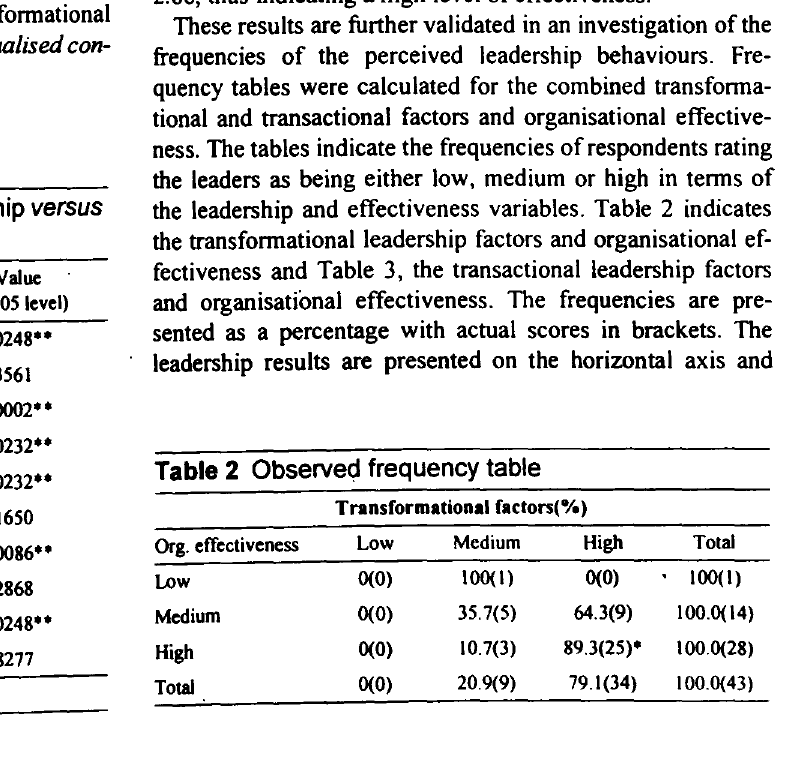
Table 1 Pearson Chi-square results: leadership versus